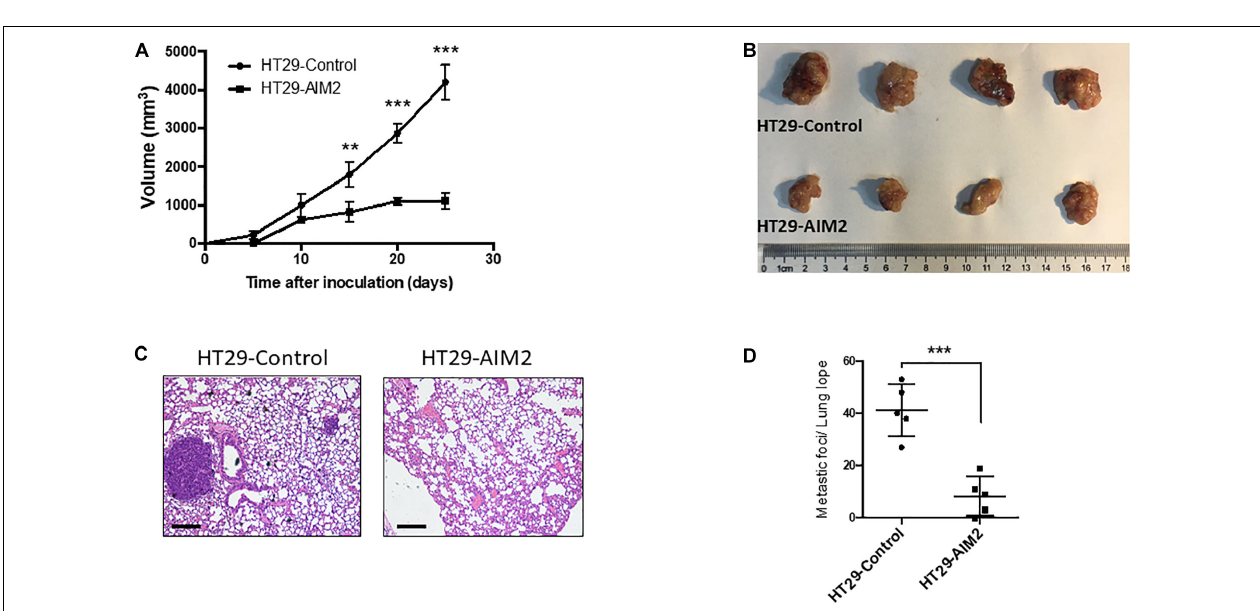
FIGURE 4 | Restoration of AIM2 expression induces BRAF-mutant CRC cell death in a caspase-1-dependent manner. (A) Western blot analysis of cleaved caspase-1, -3, and -7 in BRAF-mutant cells (HT29 and Colo205) and no BRAF-mutant cells (HCT116 and SW480) at 12 h after transfection of AIM2 plasmid. β -Actin was used as the loading control. (B) Measurement of caspase-1 activation in CRC cells transfected with AIM2 for 12 h by FLICA-1 staining. ATP (5 mM, 1 h) was used as positive controls ( n = 3, Student’s t -test). (C) Cell viability was analyzed by annexin V/7-AAD staining in HT29 and SW480 cells transfected with AIM2 for 3 days ( n = 3, χ 2 test t ). Caspase-1 knockdown was confirmed by western blot (WB). * p < 0.05, ** p < 0.01, *** p < 0.001.